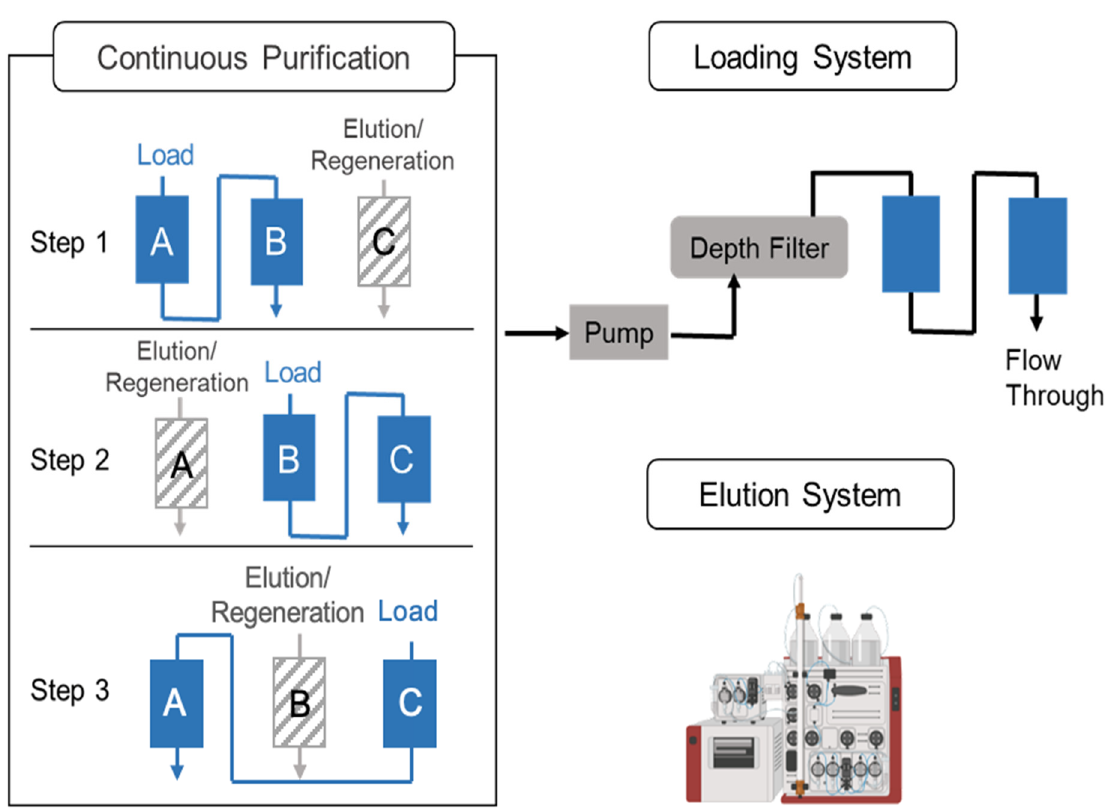
Figure 1. The schematic of continuous flow chromatography, including the loading system and the elution system.